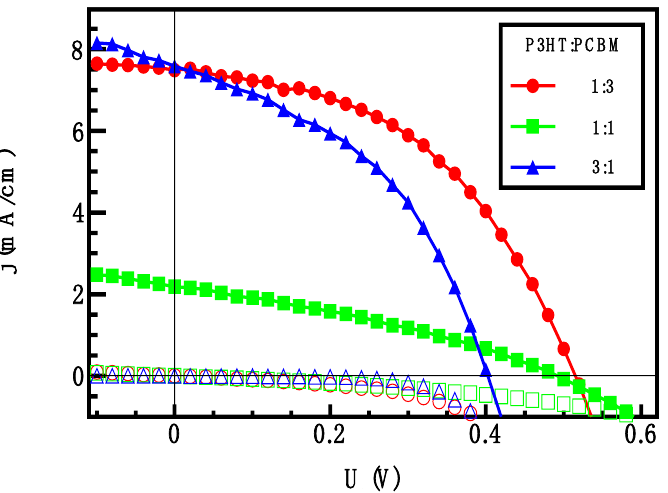
Figure 6. Current-voltage characteristics of solar cells in dark (hollow symbols) and under AM1.5 illumination (filled symbols) as a function of P3HT:PCBM ratio. Table 4. Principal OSCs figures of merit: JSC — Current Density, VOC — Open circuit Voltage, FF — fill factor, η— power efficiency.